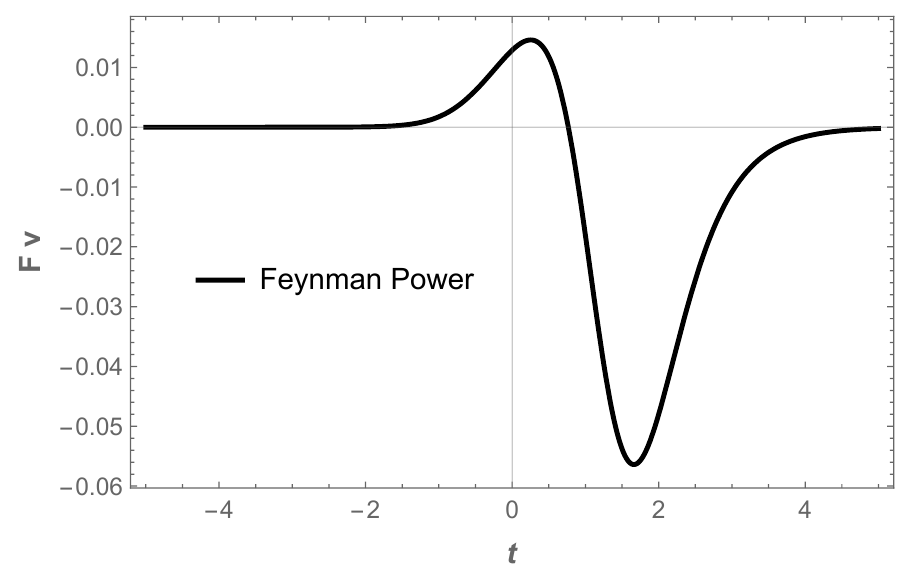
Figure 2. The Feynman power, F · v , associated with the self-force, F (3), of the GO trajectory (6), as a function of time and at final constant speed, s = 0.9, i.e., Equation (8), with κ = 1. This plot illustrates the Feynman power dies off asymptotically, has a period of negative radiation reaction, and is also consistent with a physically finite amount of total radiation energy